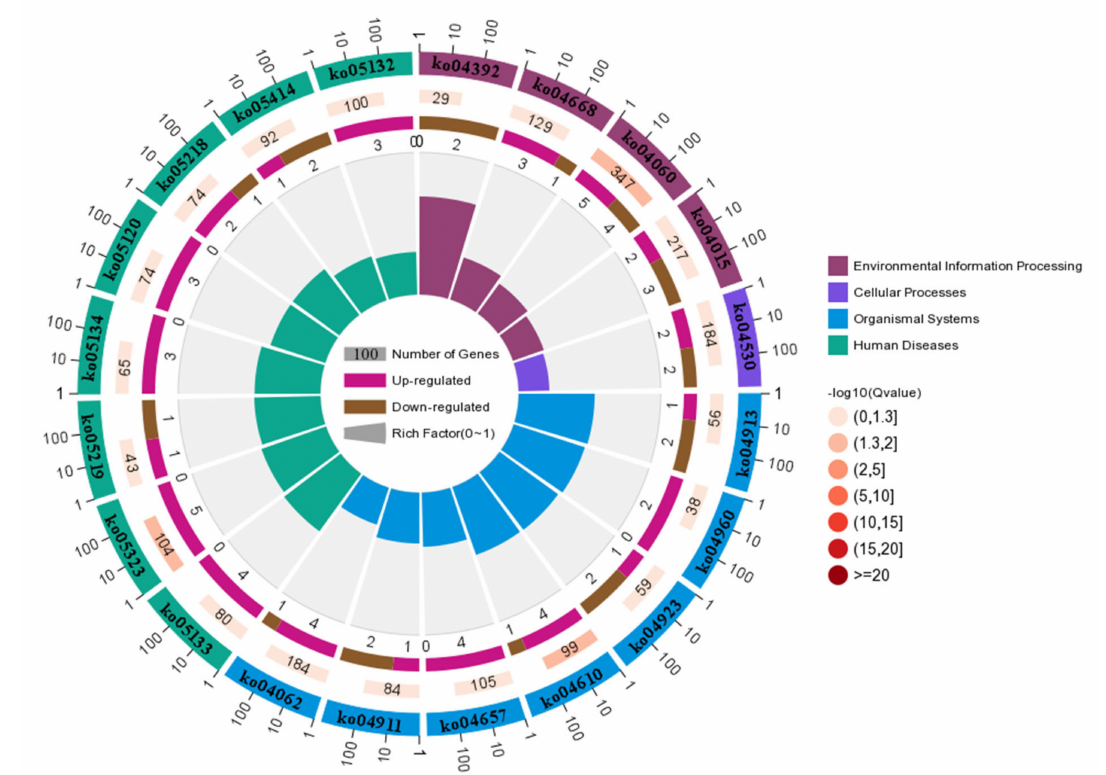
Figure 8. KO enrichment circle diagram of the KEGG_A_class: The first circle: the first 20 pathways of enrichment; outside the circle is the coordinate ruler of the number of genes. Different colors represent different A classes. The second circle: the number of pathways in the background genes and the Q value. The more genes, the longer the bar, the smaller the Q value, the redder the color. The third circle: the bar graph of upregulated gene ratio, wherein dark purple represents the upregulated gene ratio and light purple represents the downregulated gene ratio; the specific value is shown below. The four circles: Rich factor value of each pathway (the number of differences in the pathway divided by all the numbers); background grid lines each grid represent